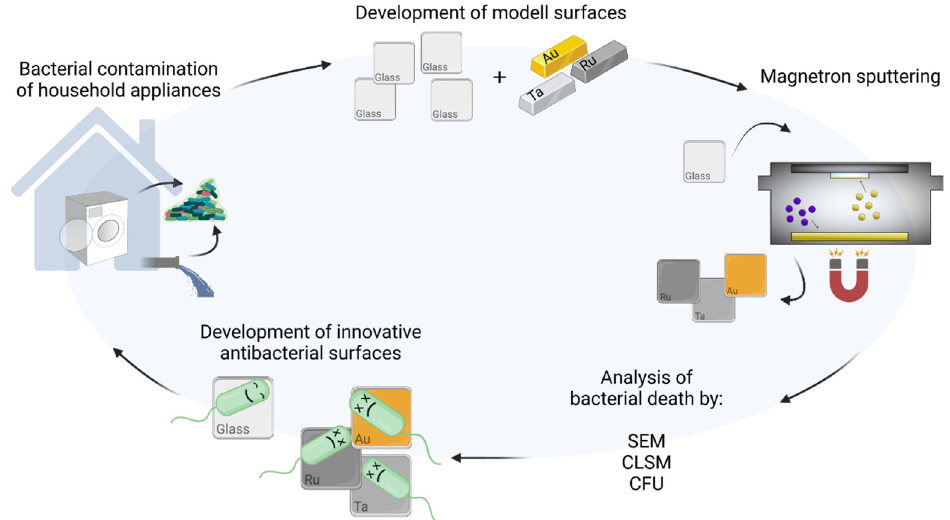
Figure 1. Scheme of the experimental design. On the left image, the problem of bacterial contamina- tion in household appliances (such as washing machines or pipes) is depicted. The next step was to develop antibacterial metal surfaces by magnetron sputtering of gold, ruthenium and tantalum on glass slides (top and right images). These surfaces were then analyzed for antibacterial properties by SEM, CLSM and CFU (bottom images). While on glass slides bacterial growth was vital, metal- sputtered surfaces inhibited bacterial growth of Pseudomonas aeruginosa. Scheme was created with BioRender.com (accessed on 10 September 2022).